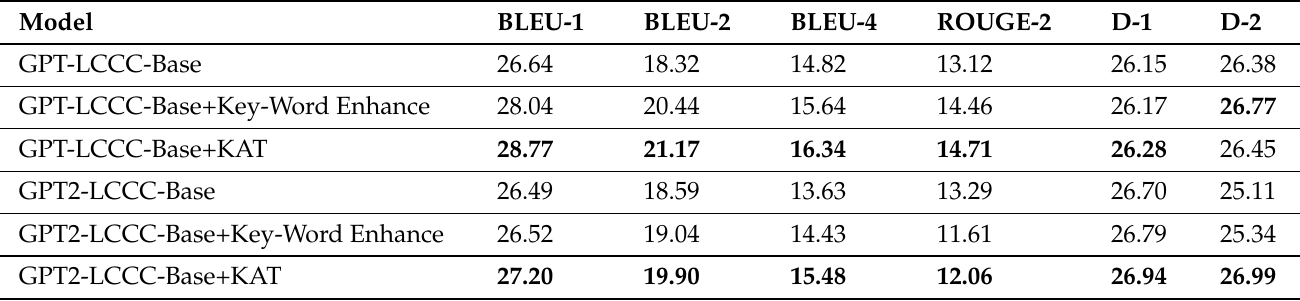
Table 4. Ablation Analysis on Chinese Daily-Dialog Dataset. For each evaluation metric in every column, the best result is highlighted in